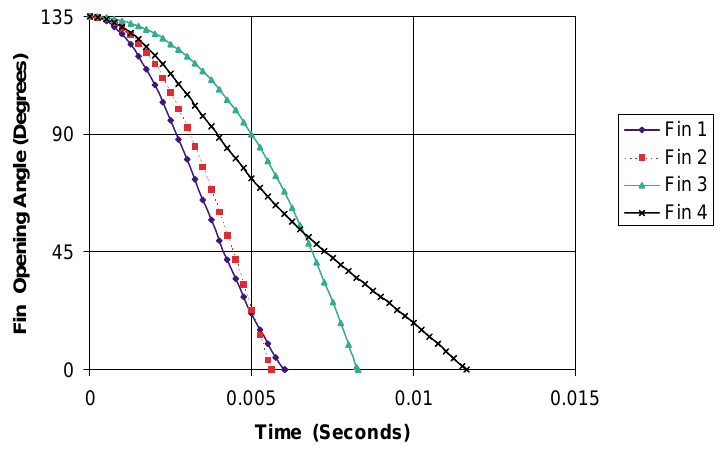
Fig. 13. Fin opening angle as a function of time, five degrees of yaw, 30 Hz spin